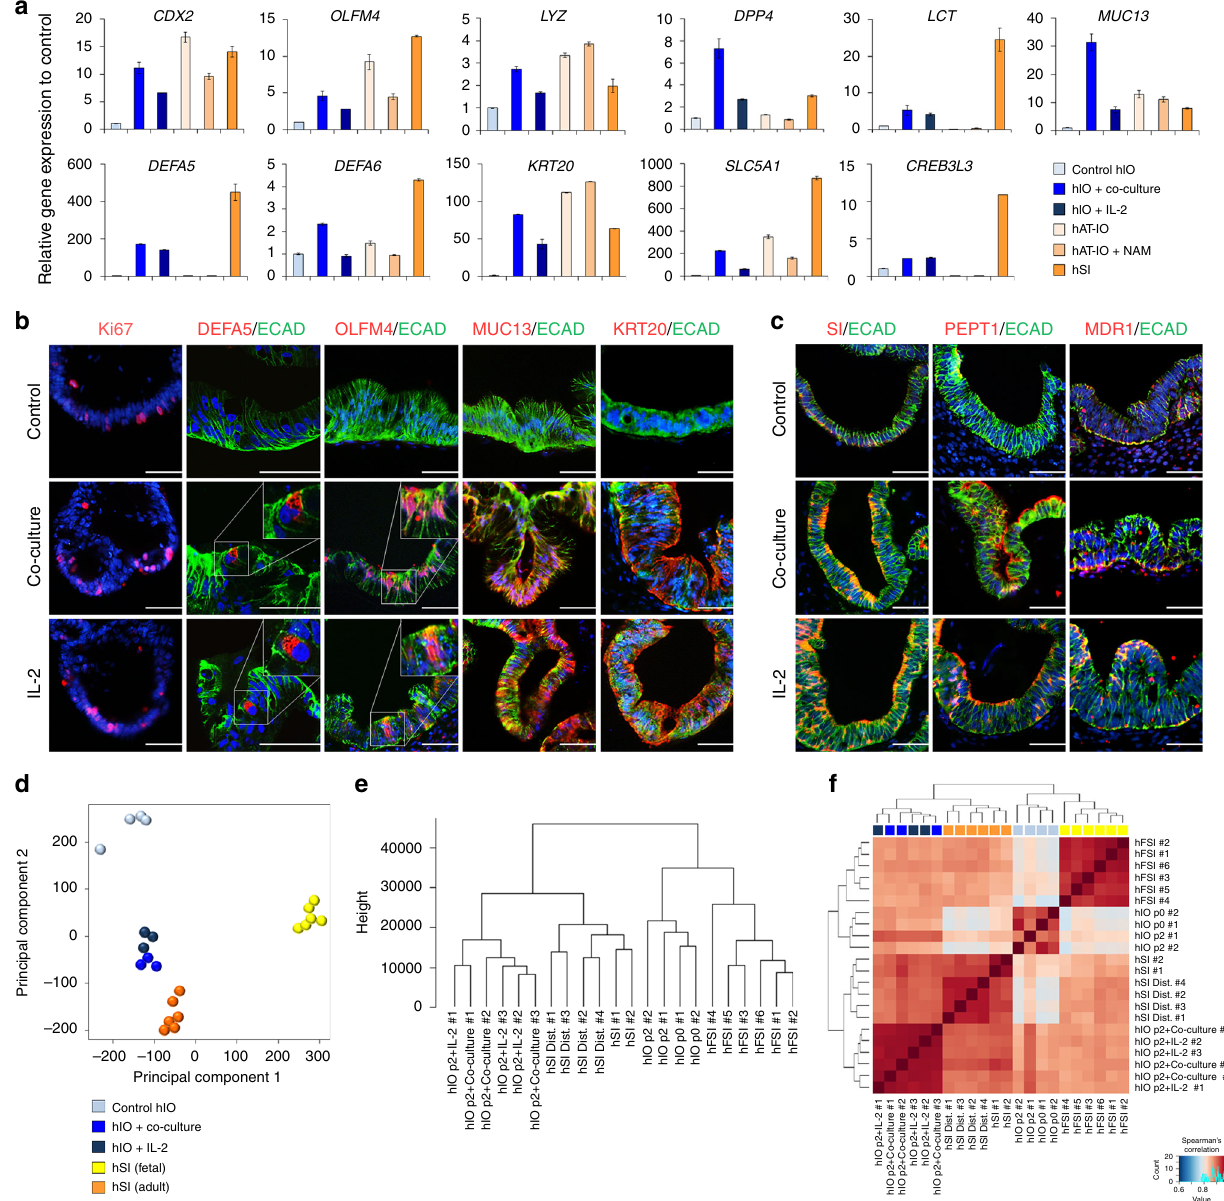
Fig. 3 Co-cultured or IL-2-treated hIOs express the markers of mature small intestine. a qPCR analysis of the expression of markers of intestinal maturation in control, co-cultured and IL-2-treated hIOs, human adult tissue-derived intestinal organoids (hAT-IOs) cultured in the presence or absence of nicotinamide (NAM), and hSI. NAM was used to improve the culture ef fi ciency of hAT-IOs. Fold changes in expression level are relative to control hIOs. b Immuno fl uorescent staining of control, co-cultured and IL-2-treated hIOs with a proliferation marker (Ki-67), an epithelial marker (ECAD) and mature intestinal markers (DEFA5, OLFM4, MUC13, and KRT20). Scale bar, 50 μ m. c Immuno fl uorescent staining for the intestinal enzyme sucrase-isomaltase (SI) and intestinal transporters (peptide transporter 1, PEPT1; multidrug resistance protein 1, MDR1). Scale bar, 50 μ m. d PCA of the RNA-sequencing datasets for control hIOs ( n = 4), co-cultured hIOs (hIO + co-culture, n = 3), IL-2 treated hIOs (hIO + IL-2, n = 3), human fetal small intestine (hFSI) ( n = 6) and adult human small intestine (hSI) ( n = 6). e A dendrogram based on hierarchical clustering of the gene sets from the RNA-sequencing using Canberra distance. Branch lengths indicate the degree of difference between samples. f Spearman ’ s correlation was used to cluster samples and generate a heatmap. Red indicates the highest level of similarity between samples and blue indicates the lowest level of similarity. Data are presented as mean values of replicates ± SEM transplantation (Fig. 5a and Supplementary 10b). Intestinal cell with Paneth cell marker (LYZ) and intestinal stem cell marker type-speci fi c markers were detected in all hIOs (Supplementary (ASCL2), respectively, and RNA fl uorescence in situ hybridiza- Fig. 10c), whilst markers of intestinal maturation were evident tion (FISH) (Supplementary Fig. 11a, b). Quantitative analysis only in the transplants of in vitro-matured hIOs (Fig. 5b). DEFA5 also showed that there were signi fi cantly more DEFA5- and and OLFM4 expression was exclusively observed in the co- OLFM4-positive cells in the in vitro-matured hIOs than in the cultured and IL-2-treated hIOs and con fi rmed by co-staining control hIOs (Fig. 5c). In addition, a brush-border enzyme, SI,